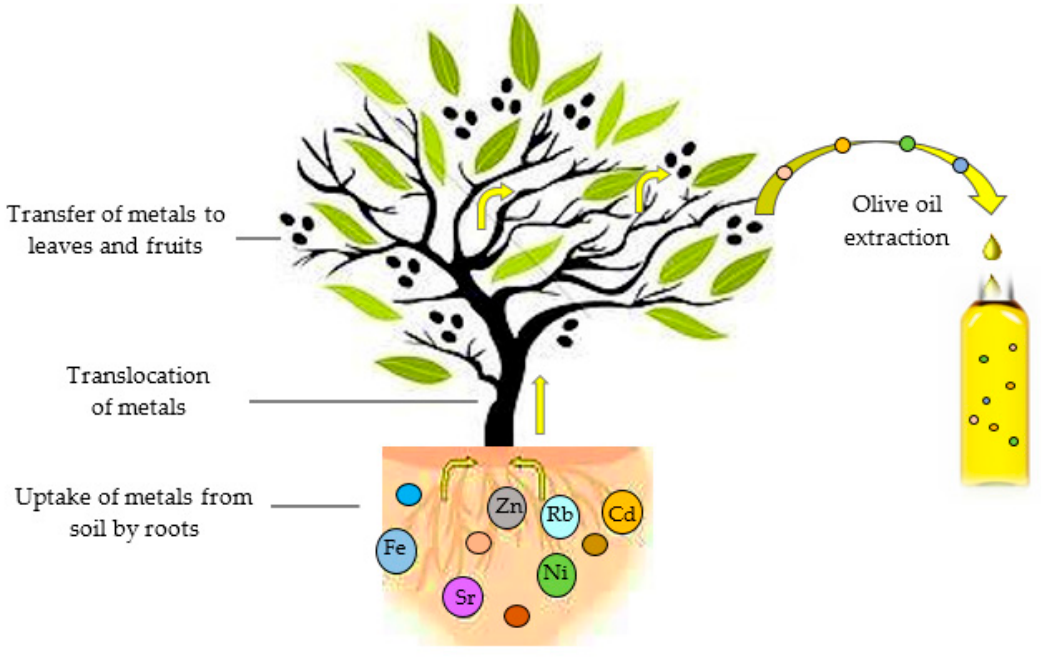
Figure 2. Schematic pathways of how some trace elements arrive in olive oil from the soil.